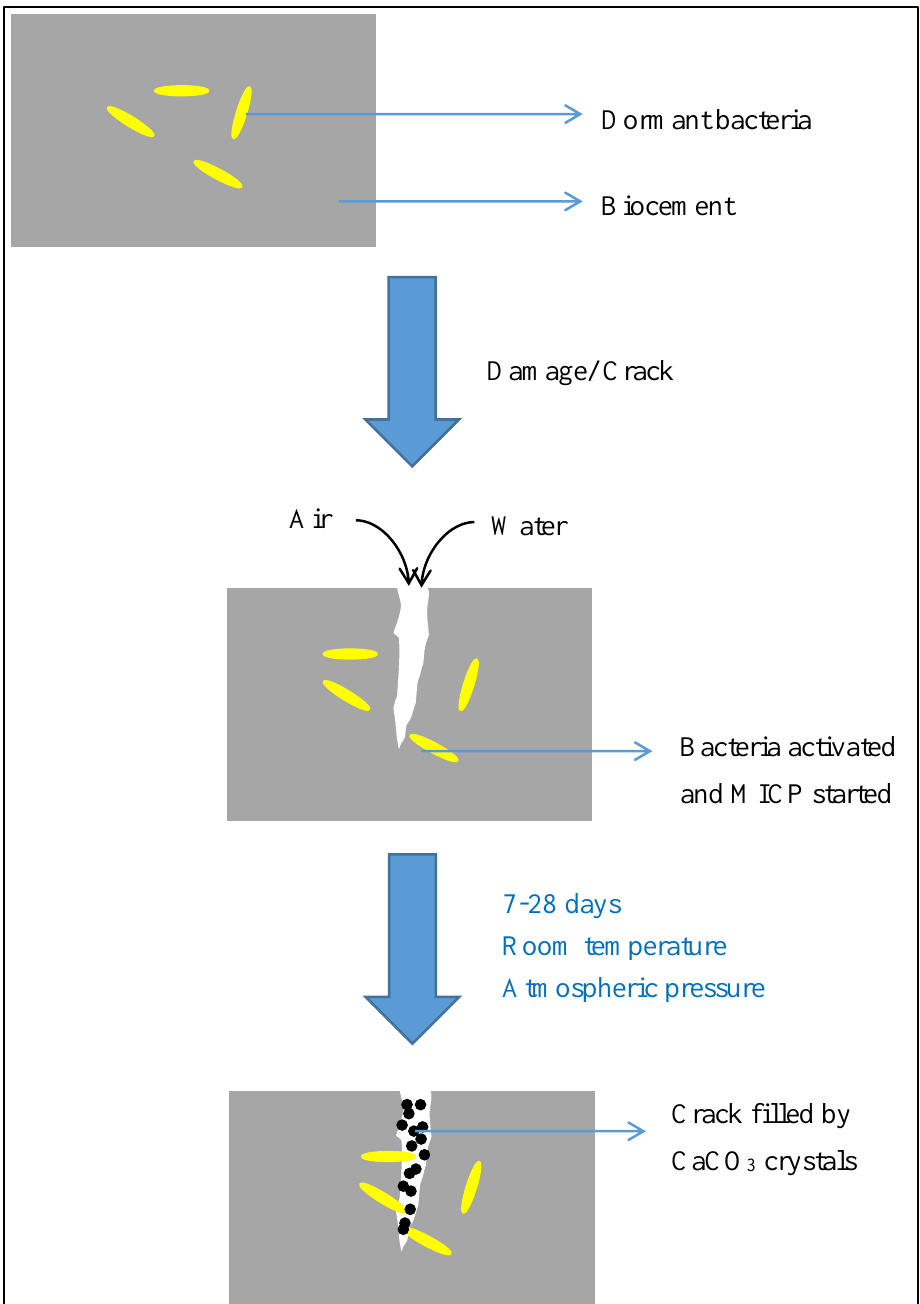
Figure 2. Schematic diagram for self-healing of biocement.